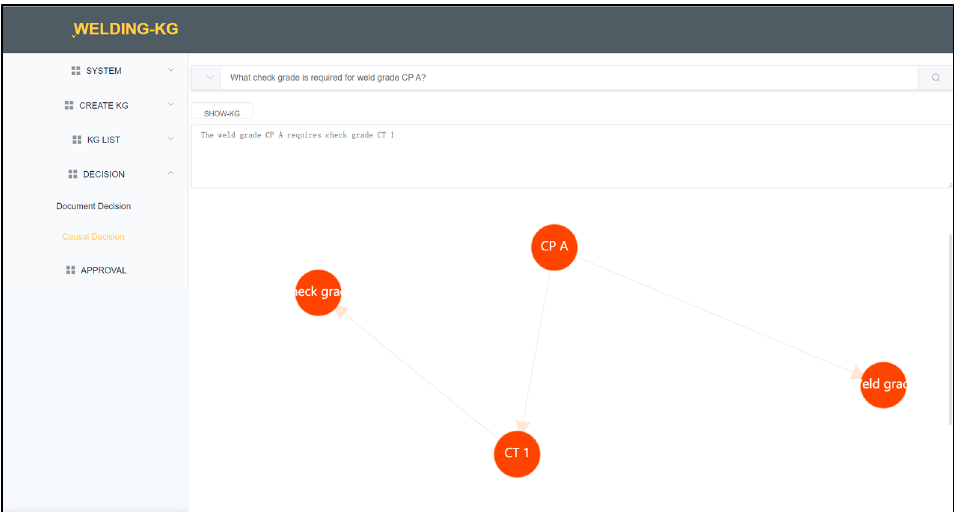
Figure 8. Causal decision process.